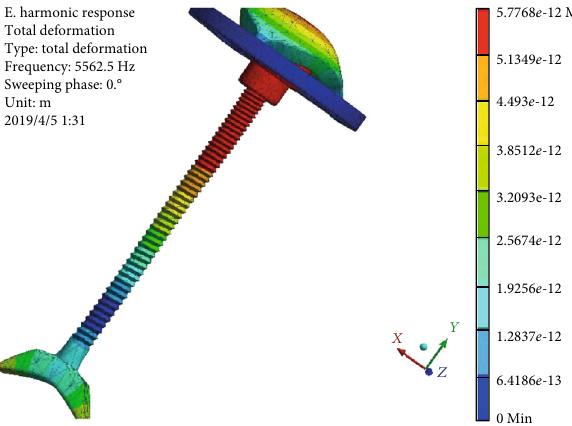
Figure 13: Displacement cloud diagram of prosthesis with the copper alloy